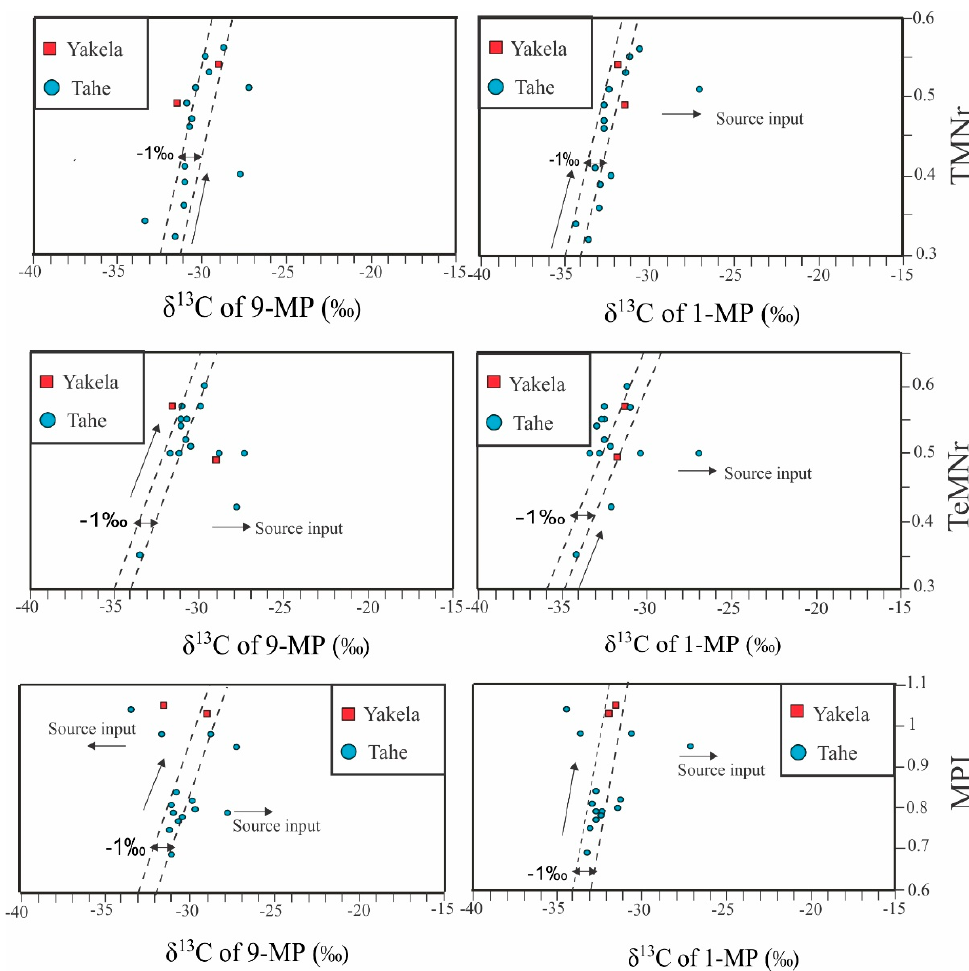
Figure 13. Cross plots of weighted mean δ 13 C values of individual aromatic isomers from Yakela and Tahe fields versus maturity indicator parameters.